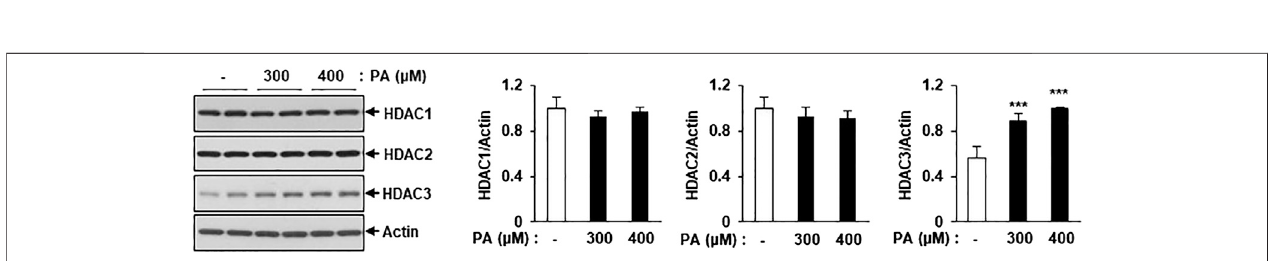
FIGURE3| TreatmentofPAincreasedtheclassIHDACsproteinlevelinC2C12myotubes.C2C12myotubeswereincubatedwith300or400 μ M PAfor12 hand class1 HDAC protein levels were detected by Western blot. *** p < 0.001 vs. PA-untreated cells.